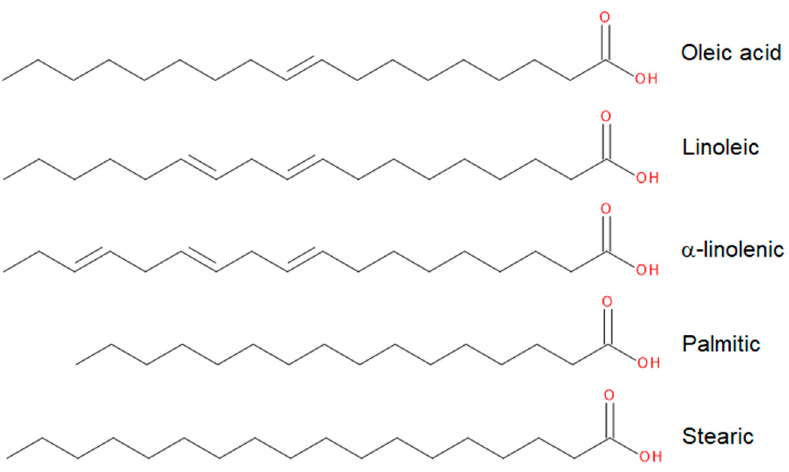
Figure 1. The main fatty acids present in rapeseed oil. Polyurethanes were synthesized from a Rokopol ® F3000 and Rokopol ® V700 polyols obtained from the PCC Group (Brzeg Dolny, Poland), with the addition of glycerol acquired from Sigma Aldrich (Pozna´n, Poland). The polymeric methylenediphenyl-4,4 ′ - diisocyanate (pMDI) SPECFLEX NF 434, acquired from M. B. Market Ltd. (Baniocha, Poland) was used as an isocyanate component. The solution of potassium acetate PC CAT ® TKA30 from Performance Chemicals (Belvedere, UK), 33 wt % solution of 1,4-diazabicyclo [2.2.2]octane in dipropylene glycol (Dabco33LV from Air Products (Allentown, PA, USA)), and dibutyltin dilaurate (DBTDL) from Sigma Aldrich (Pozna´n, Poland) were applied as catalysts. Distilled water was used as a chemical blowing